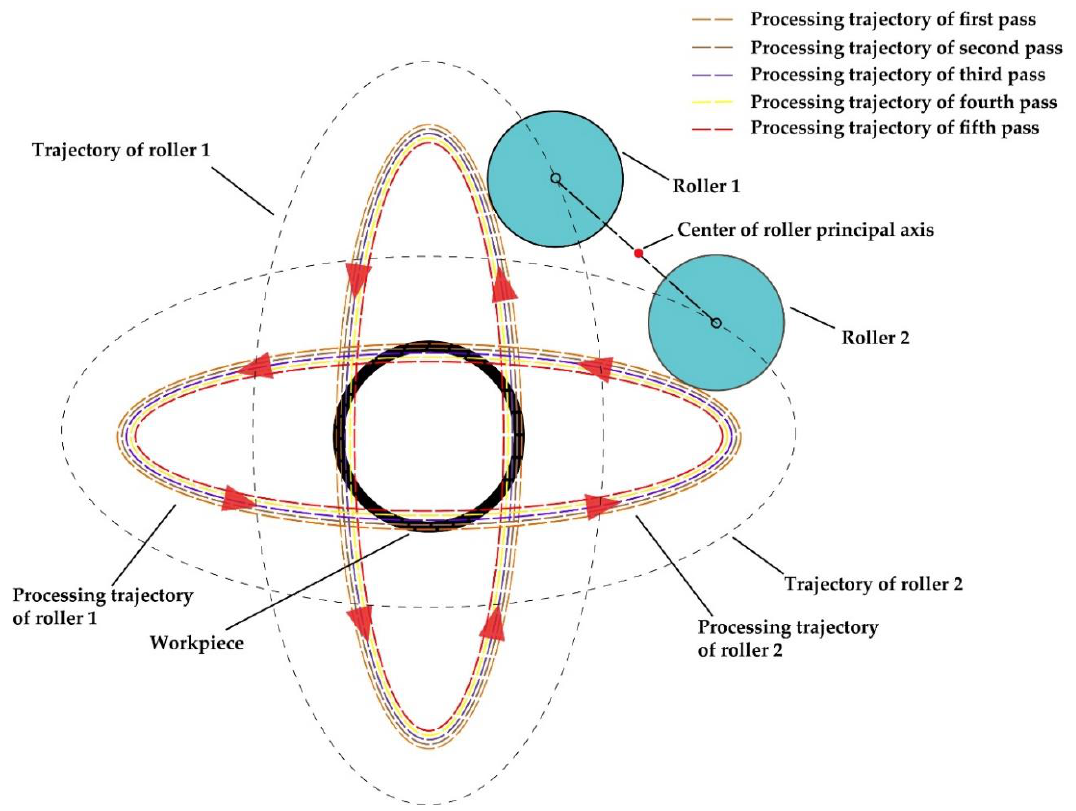
Figure 3. Schematic illustration of the roller trajectories obtained using the non-circular spinning method based on hypocycloid